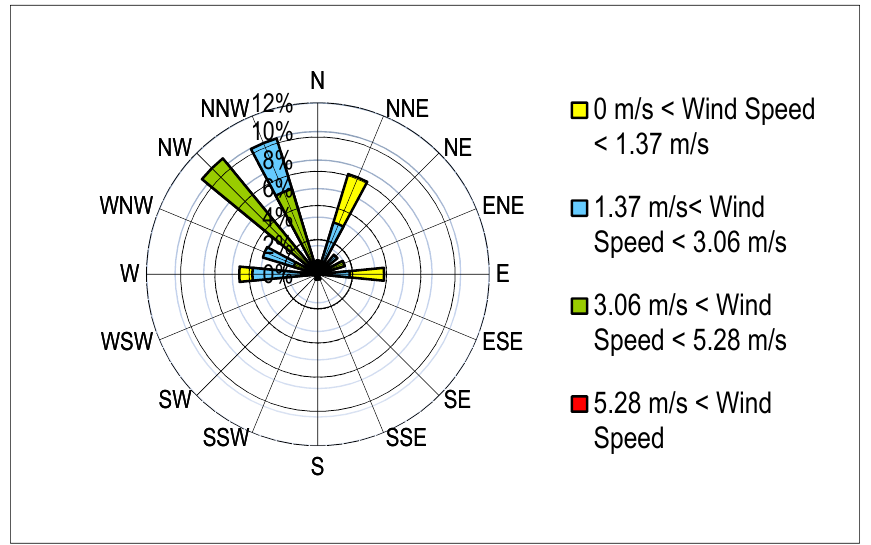
Figure A1. The wind speed and direction were distributed at the study areas. Table A1. The air temperature, relative humidity, and wind speed observed during the year. Month